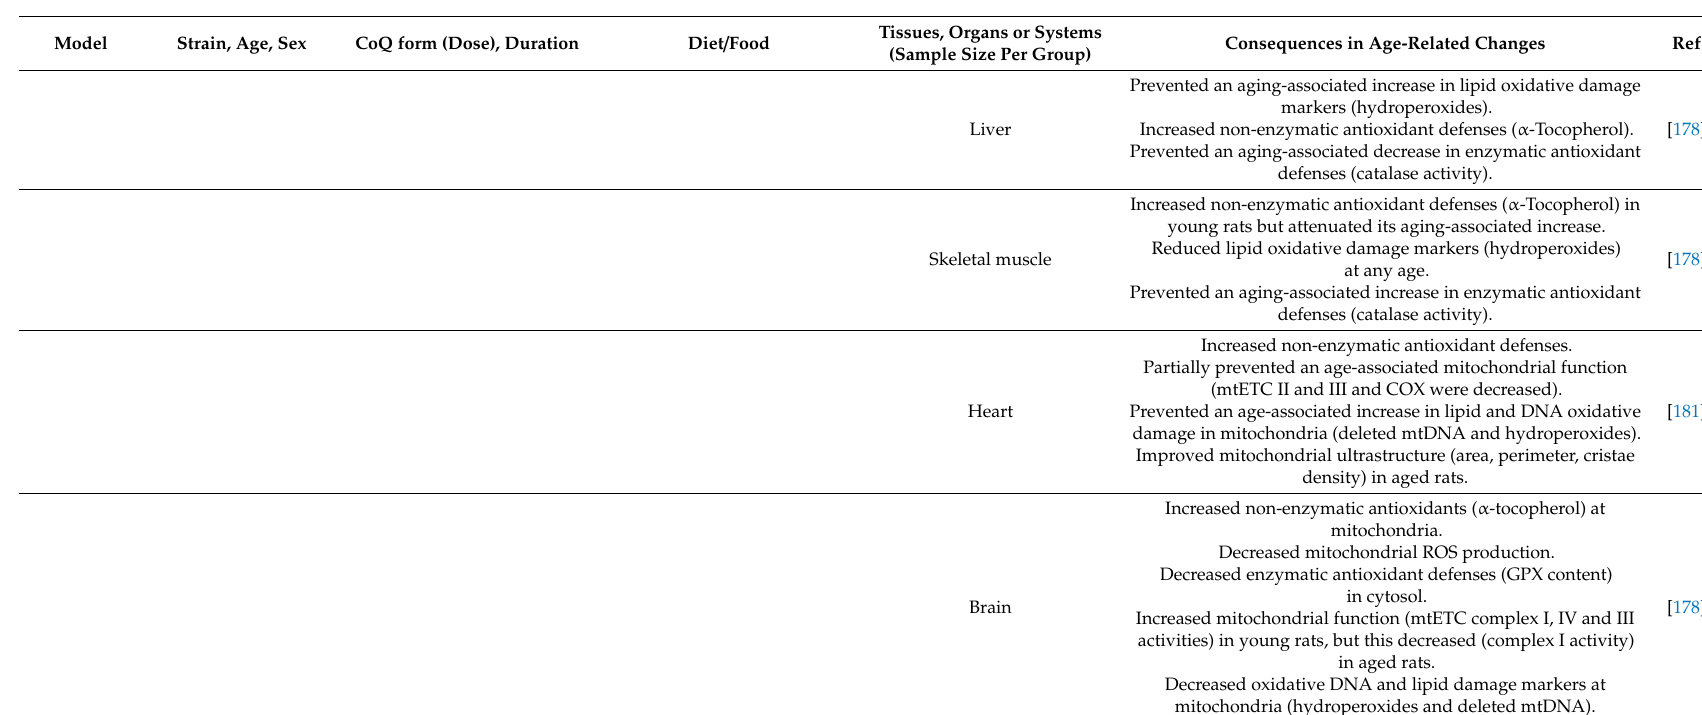
Model Strain, Age, Sex CoQ form (Dose), Duration Diet / Food